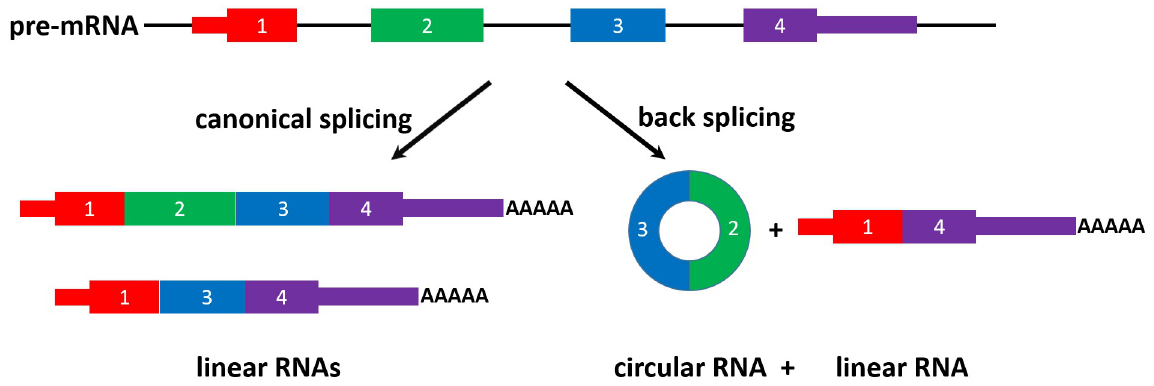
Fig 1. Illustration of linear RNA and circRNA